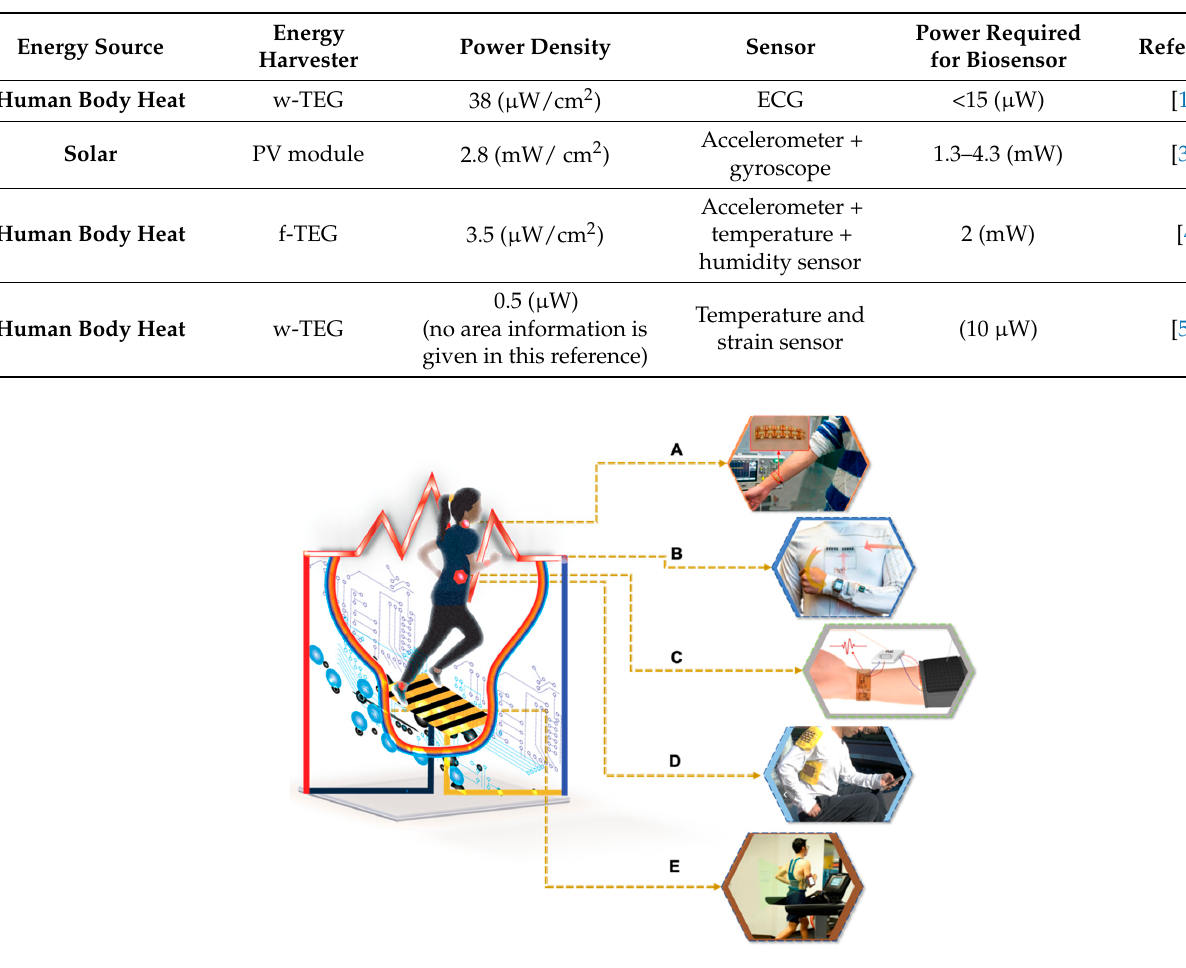
Figure 4. Self-powered wearable health monitoring system, powered by wearable thermoelectric generator and the prospective WTENG application on the human body: ( A ) a wearable thermoelec-